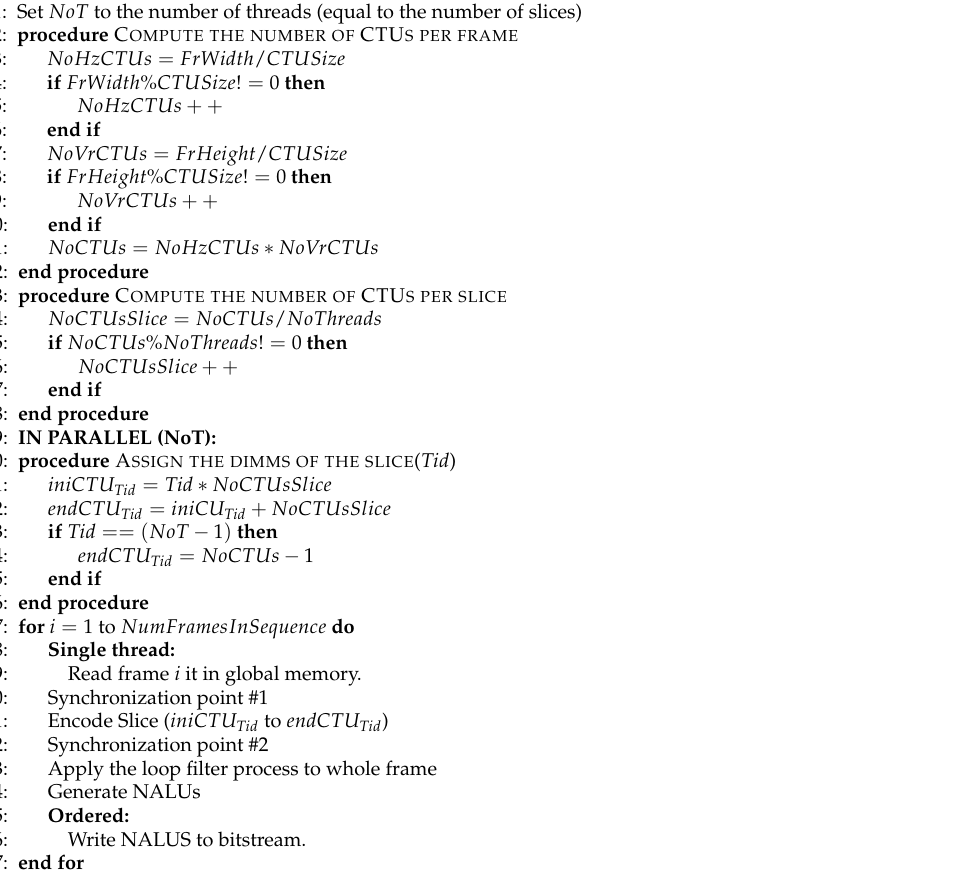
Algorithm 1 JEM-SP-Sync: Slice-based parallel algorithm with synchronization